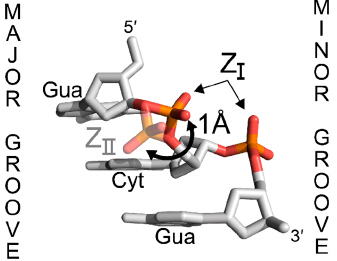
Figure 3. Syn -p- anti steps can adopt two phosphate conformations in Z-DNA. While all anti -p- syn steps adopt a nearly uniform Z I phosphate position, syn -p- anti are more flexible and can adopt two distinct phosphate positions, Z I or Z II . Z I is more prevalent and is characterized by the phosphate pointing in towards the minor groove. In Z II , the phosphate is rotated away from the minor groove by 1 Å towards the major groove surface. It is unclear if Z-RNA can adopt a similar Z II position. Figure adapted from PDB: 7JY2 [33].